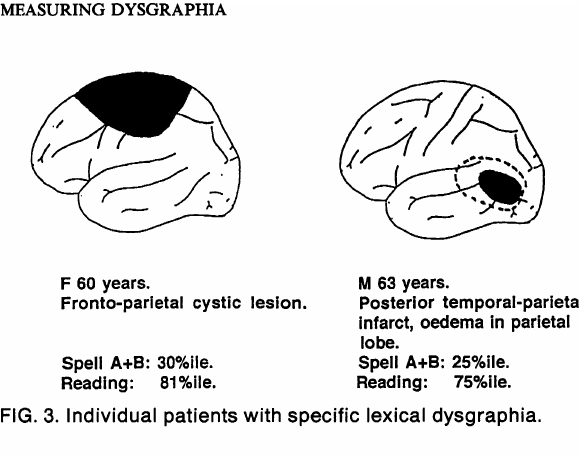
FIG. 3. Individual patients with specific lexical